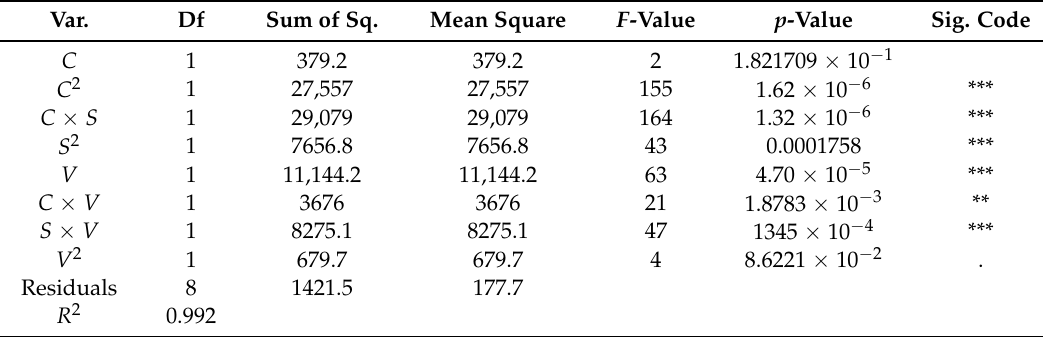
Table 8. ANOVA table for the “RS” quadratic model.